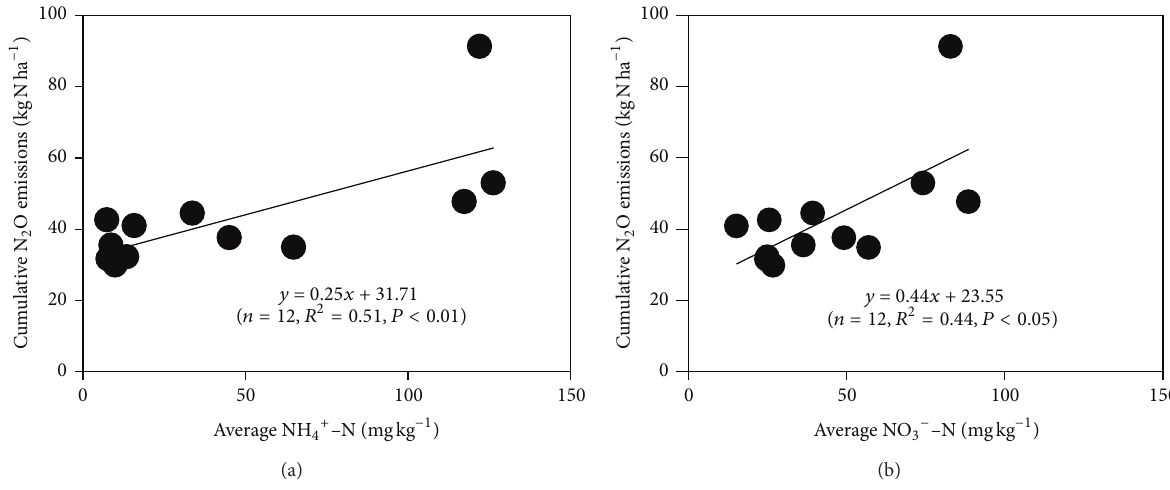
Figure 3: Relationships between the annual cumulative N 2 O emissions and the annual average (a) NH 4+ –N and (b) NO 3− –N contents. The given data are obtained from all of the 12 subplots.